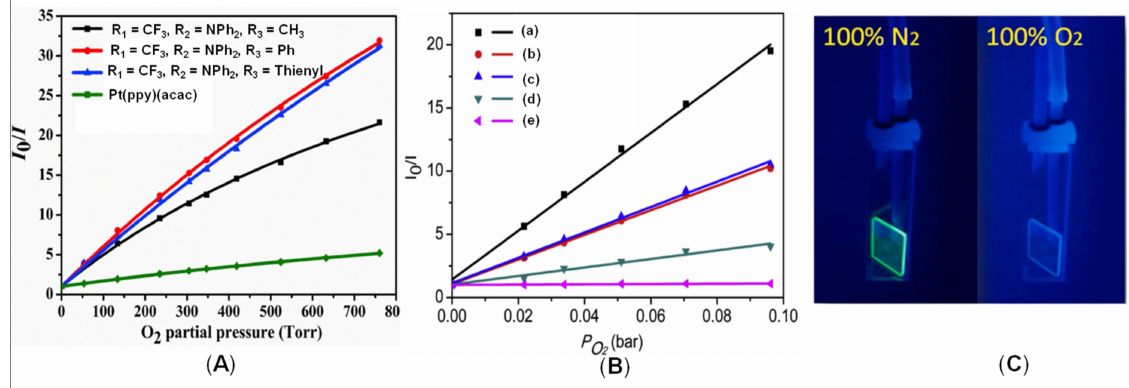
Figure 15. Stern Volmer plots of ( A ) complex 57 immobilized on EC films, ( B ) complex 21 in THF (a: R 1 = R 2 = Me; R 3 = R 4 = R 5 = H; R 6 = C 6 H 5 , b: R 1 = R 2 = Me; R 3 = R 4 = R 5 = H; R 6 = 2,4-C 6 H 3 F 2 , c: R 1 = R 2 = Me; R 3 = R 4 = R 5 = R 6 = H, d: R 1 = R 2 = Me; R 3 = R 4 = R 5 = H; R 6 = F, e: R 1 = R 2 = Me; R 3 = R 5 = H; R 4 = R 6 = F) and ( C ) The luminescence photographs of 59 film under 100% N 2 and 100% O 2 (excited at 365 nm). Reproduced with permission from ref.